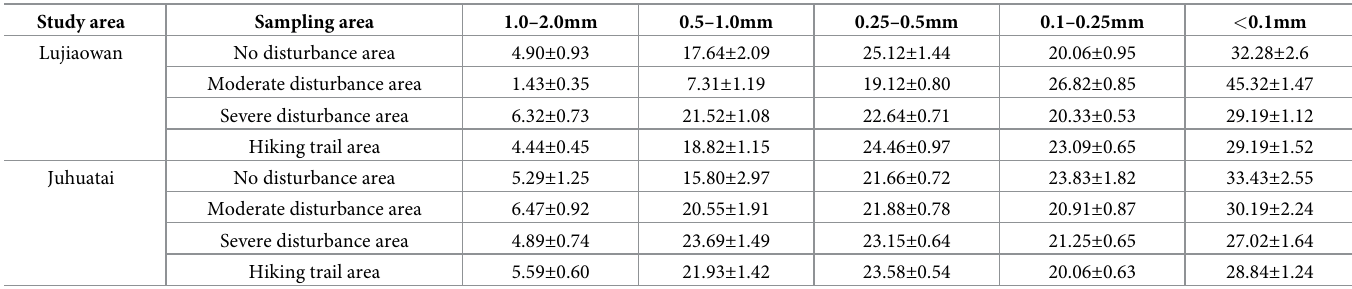
Table 2. Soil particle size composition.